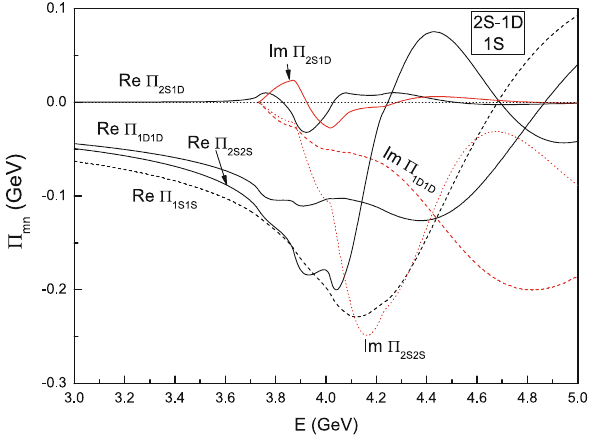
Fig. 1 Real and imaginary parts of (cid:6) mn in 2 S − 1 D sector and Real part of (cid:6) mn in 1 S sector